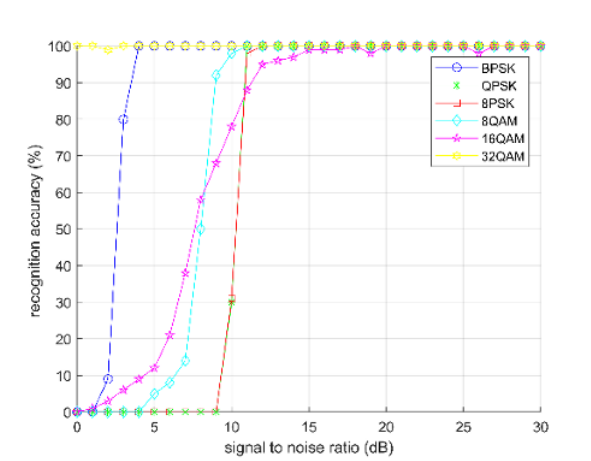
Fig. 3. PRI sorting at 20%